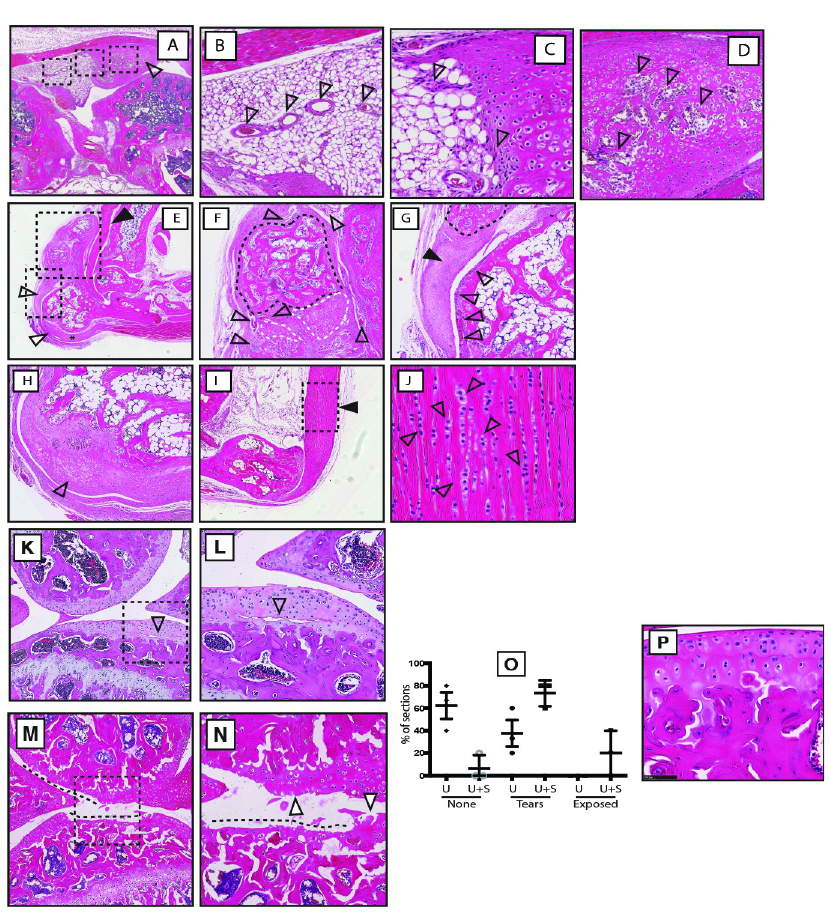
Fig 6. Smo LoF enhances the Ubr5 mt AC phenotype. (A) Ubr5 mt + Smo LoF synovium exhibited large ectopic tissue deep to the patella and adjacent to the femur (open arrowhead). Three black dashed boxes, from left to right, are enlarged in (B), (C) and (D), respectively. (B) Sub-intimal synovial layer abutting the ectopic tissue was highly vascularized (arrowheads). (C) The region interfacing with the ectopic tissue harboured plump spindle-like cells and chondroid-like cells (arrowheads). (D) The core of the ectopic tissue resembled calcified cartilage undergoing endochondral ossification and harboured vascularized cavities (arrowheads). (E) Ubr5 mt +Smo LoF ankle exhibited a large ectopic structure (black arrowhead) and abnormal superficial digital flexor tendon (open arrowhead) and calcaneus (asterisk). The upper and lower dashed boxed region are enlarged in (F) and (G), respectively. (F) The ectopic mass contained bone-like (black dashed lines) and cartilaginous tissues (white dashed lines) surrounded by extensively vascularised synovium (open arrowheads). (G) The presumed superficial digital flexor tendon attached to the ectopic bone (black arrowhead), harboured chondrocytes and resembled cartilage (encircled by black dash line). The adjacent periosteum of the calcaneus was highly vascularised (open arrowheads). (H) Cartilaginous thickening of the outer calcaneus. (I) The AT was thickened. The dashed box enlarged in (J) shows columns of chondrocytes (open arrowheads). (K-N) Analysis of 12-week-old knee joints of Ubr5 mt and Ubr5 mt +Smo Lof by H&E stained histological sections of the lateral condyles. (K, L) Ubr5 mt exhibited tears in the AC (open arrowhead) and (M, N) Ubr5 mt +Smo LoF exhibited extensive loss of AC (dashed lines) and damaged apical surfaces (arrowhead). Dashed boxes in (K) and (M) indicate the enlarged regions in (L) and (N), respectively. (O) Percentage of sections bearing no damage (‘None’), tears (‘Tears’) or exposed calcified cartilage (Exposed), revealed a significance difference between the genotypes. Mean and s.e.m indicated. Chi- square test on pooled slide counts. p = 0.0027. (P’) Smo LoF AC showed no signs of AC